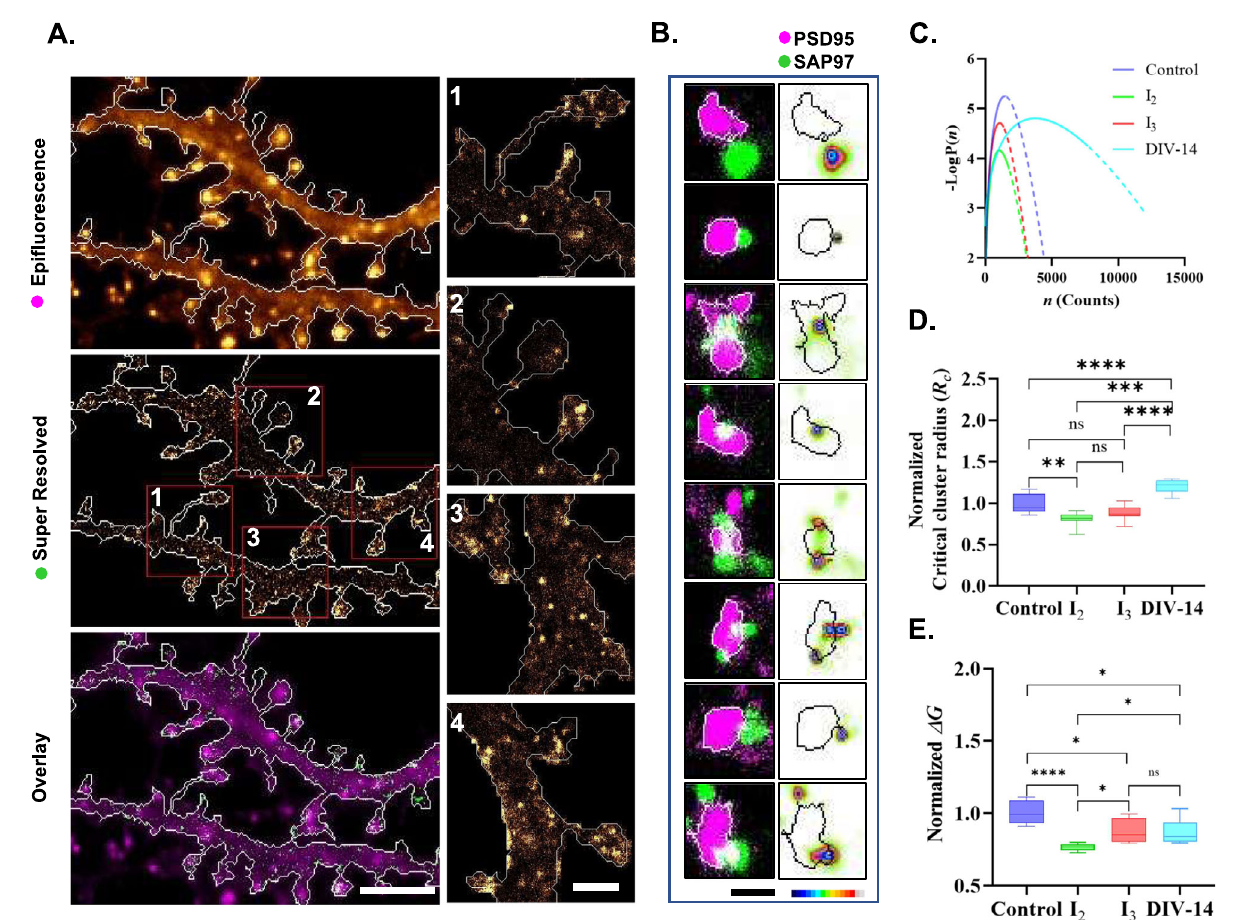
Fig. 7 Effect of SAP97/hDLG isoform compositionality on nanoscale condensates. A Ectopic expression of I 3 -hDLG::mEos in hippocampal pyramidal neurons (DIV-14) shows distinct localization in dendritic shafts and is enriched in morphologically characterized spines (epi fl uorescence). Super resolution imaging con fi rms nanoscale condensates (super resolved) formed in dendrites and synaptic compartments (overlay). Scalebar indicates 5 µ m. Insets of super resolved images (red regions, super resolved image) are presented to illustrate heterogeneity in nanoscale condensates of SAP97/hDLG in spines and dendritic shafts (1,2,3,4). Scalebar indicates 1.5 µ m. B Left panel indicates association of SAP97/hDLG condensates with a single postsynaptic density. Postsynaptic density protein PSD95 (Magenta) was identi fi ed by semiautomated analysis and its overlap with the nanoscale distribution of endogenous SAP97/hDLG (Green) is presented in white. Scalebar indicates 0.5 µ m. Right panel indicates the localization of SAP97/hDLG nanoscale condensates with respect to the nearest identi fi ed postsynaptic density (black region). Pseudo color scalebar in all microscopy images represents normalized intensity from maximum to minimum (black to white). C Plot of Δ G , derived from the probability density function, with number of molecules per cluster ( n ) indicates the combined molecular fi ngerprints of critical cluster radius and nucleation barrier between different conditions of SAP97/hDLG modulation in Neuro-2a cells and hippocampal pyramidal neurons. D The critical cluster radii of SAP97/hDLG remained similar between Neuro-2a cells ectopically expressing I 2 and I 3 isoform, while it was signi fi cantly different between untransfected neurons and Neuro-2a cells. E The nucleation barrier of SAP97/hDLG remained similar between Neuro-2a cells expressing the I 3 isoform of SAP97/hDLG and untransfected neurons, while it signi fi cantly differed between I 3 and I 2 isoforms and untransfected Neuro-2a cells. The box represents 25% percentile, median and 75% percentile (Source Data), while the whiskers represents the minimum and maximum values (Source Data). N = 9 cells for each condition. Data are cumulated from three experiments. * p < 0.05, ** p < 0.01, **** p < 0.0001 (Supplementary Table 6). Source data are provided as Source Data fi